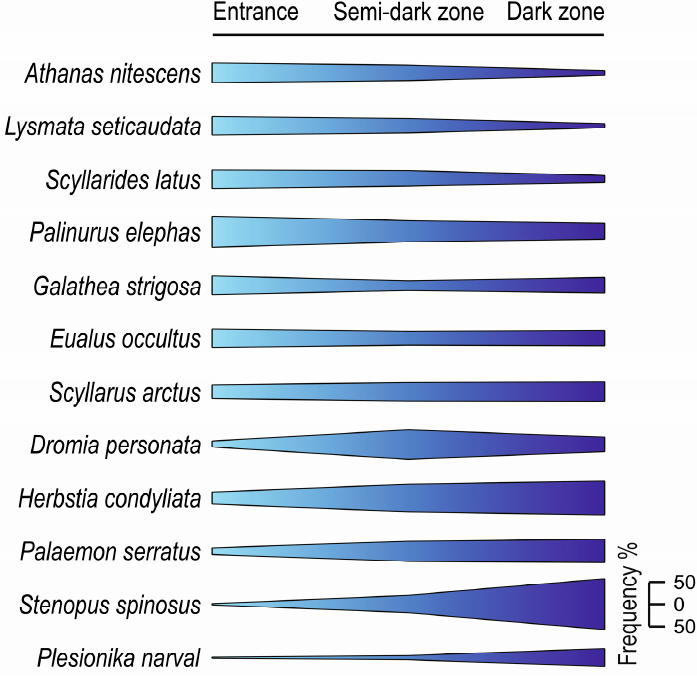
Figure 6. Kite diagrams illustrating cave zone preference for selected cave decapod species.